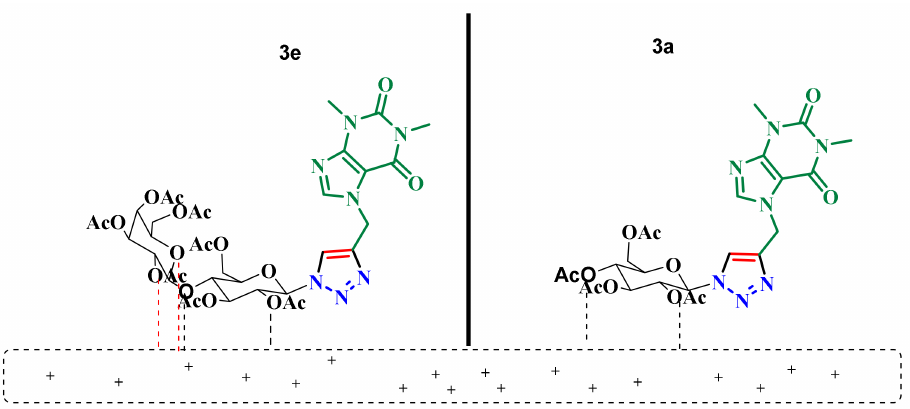
Figure 8. Comparison of inhibitor adsorption by compound 3e and 3a in metal